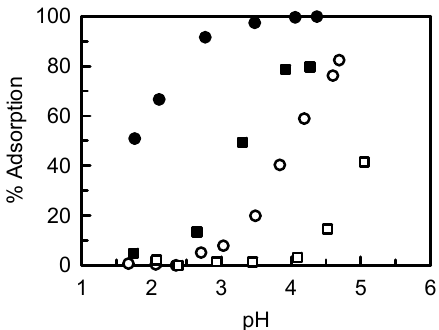
Figure 14. % adsorption (A) of some metal ions by SAJR at different equilibrium pH values [14]. (Copyright 2003 by The Minerals, Metals & Materials Society. Reprinted with permission).